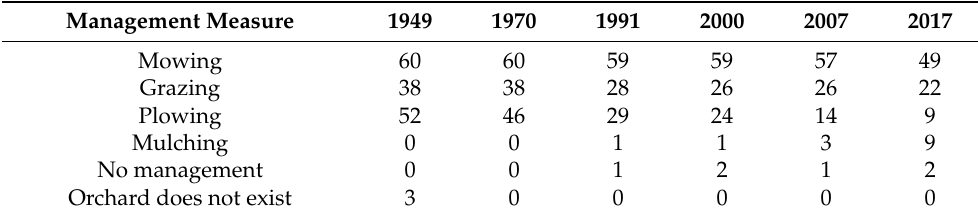
Table 1. Changes in the occurrence of the main management measures used in traditional orchards over the period 1949–2017.